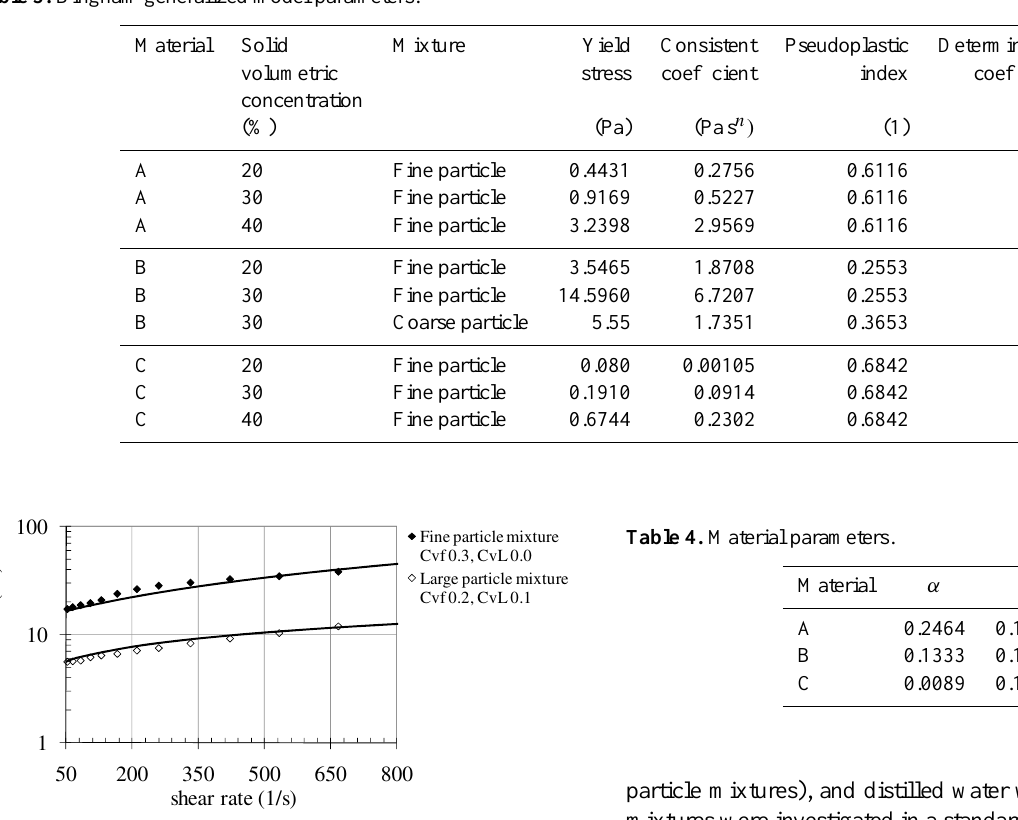
Fig. 8. Material B: effect of maximum particle diameter for C v equal to 30%.